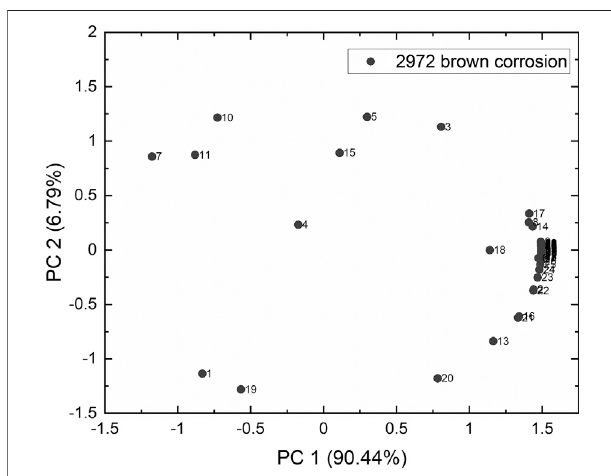
FIGURE 9 | Loadings plot of PC1 vs PC2 for the brown corrosion on object 2,972, 100 pulses.